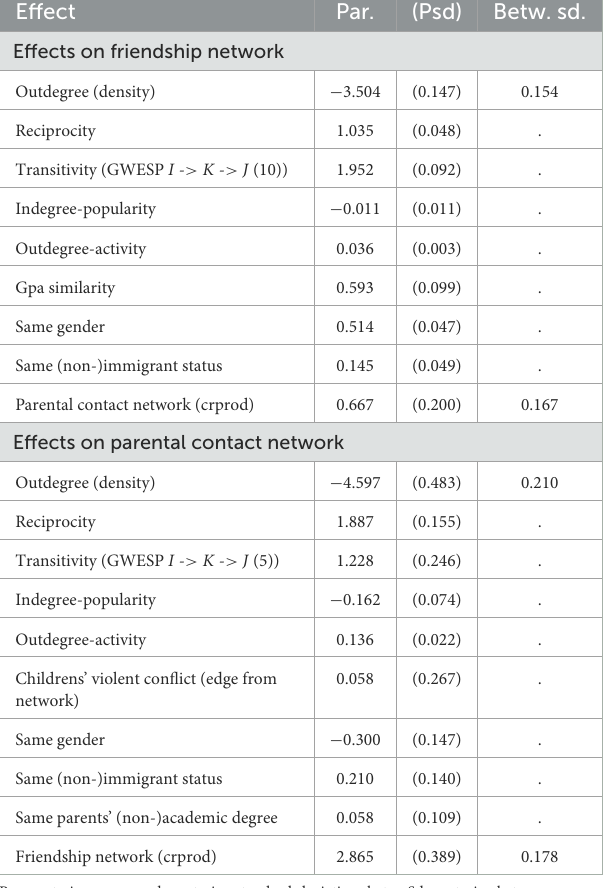
TABLE 2 Co-evolution of adolescents friendships and contact among their parents, Bayesian multilevel SAOM k = 10 classes, N = 248 students. Effect Par. (Psd) Betw.